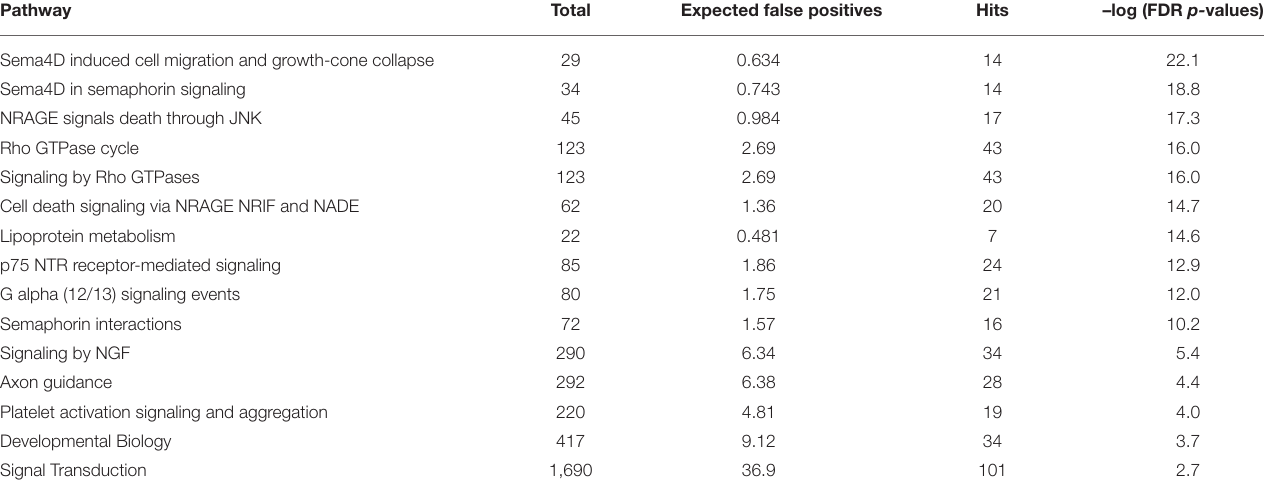
TABLE 3 | Gene ontology and functional pathway enrichment analysis.